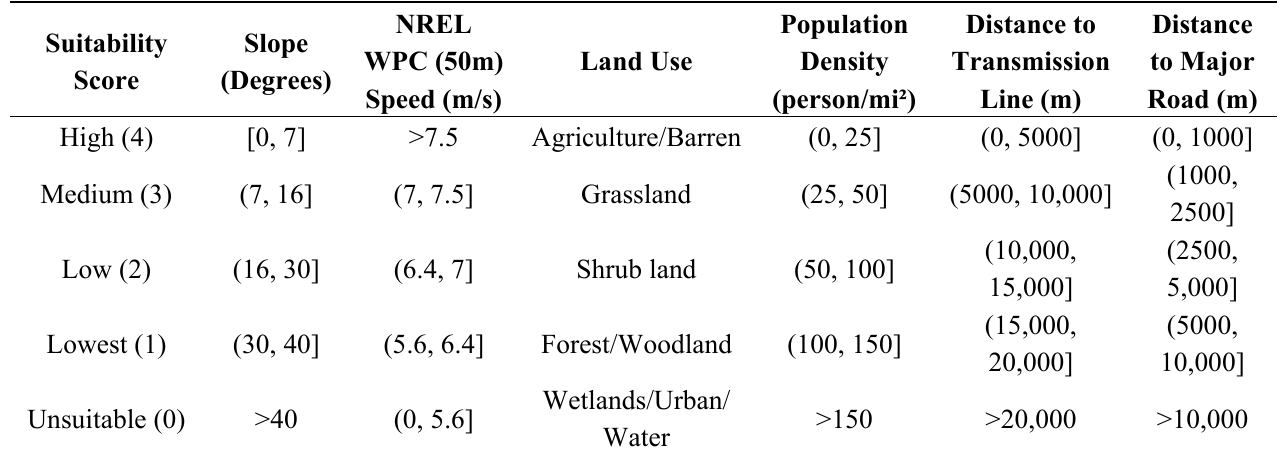
Table 3. Rating scheme for multiple modeling criteria.